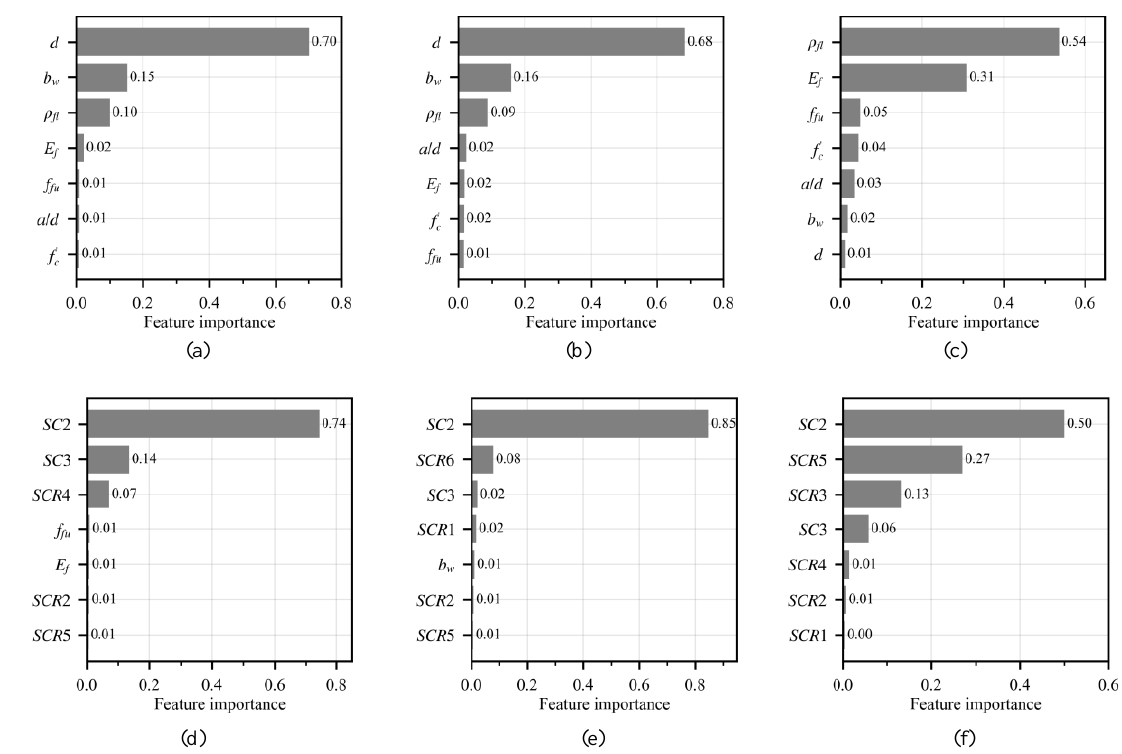
Figure 7. Relative importance of input features of the basic ML models (( a ) Decision Tree; ( b ) Random Forest; ( c ) XGBoost) and ML models with additional features (( d ) Decision Tree; ( e ) Random Forest; ( f ) XGBoost).